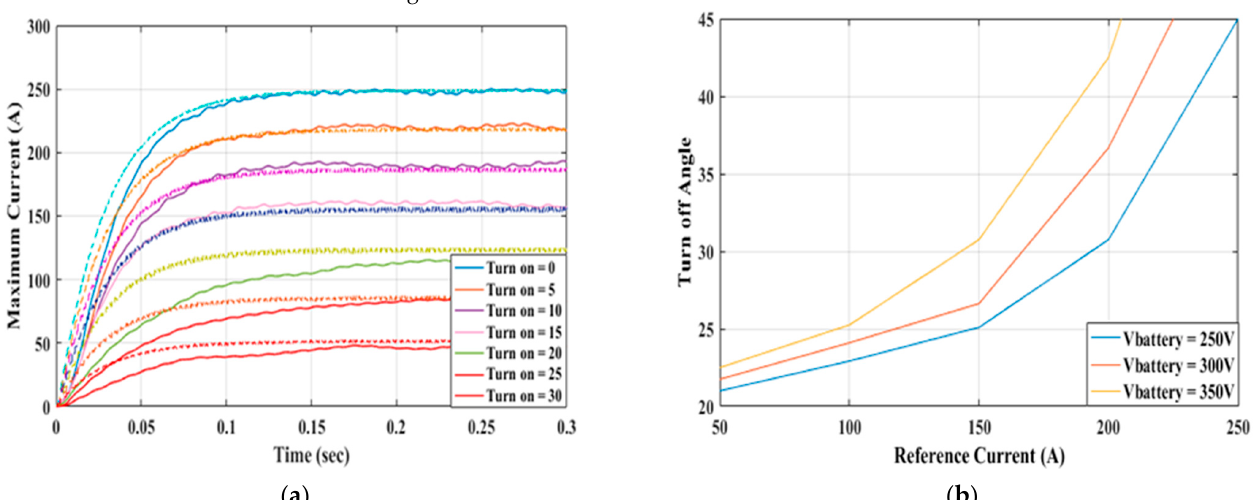
Figure 22. Opal-RT real-time simulator response for turn-off angle control; ( a ) effect of initial turn-on angle on maximum current (solid traces for experimental results and dashed traces for simulation), ( b ) effect of battery voltage on turn-off angle at different reference currents.